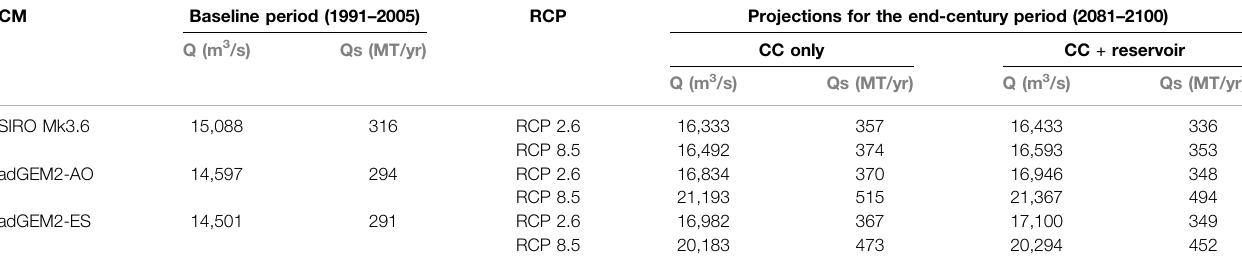
TABLE 7 | Projected mean annual stream fl ow and sediment loads at Pyay from the three GCMs for the baseline period (1991 – 2005) and end-century period (2081 – 2100). Q is stream fl ow and Qs is sediment load. CC denotes climate